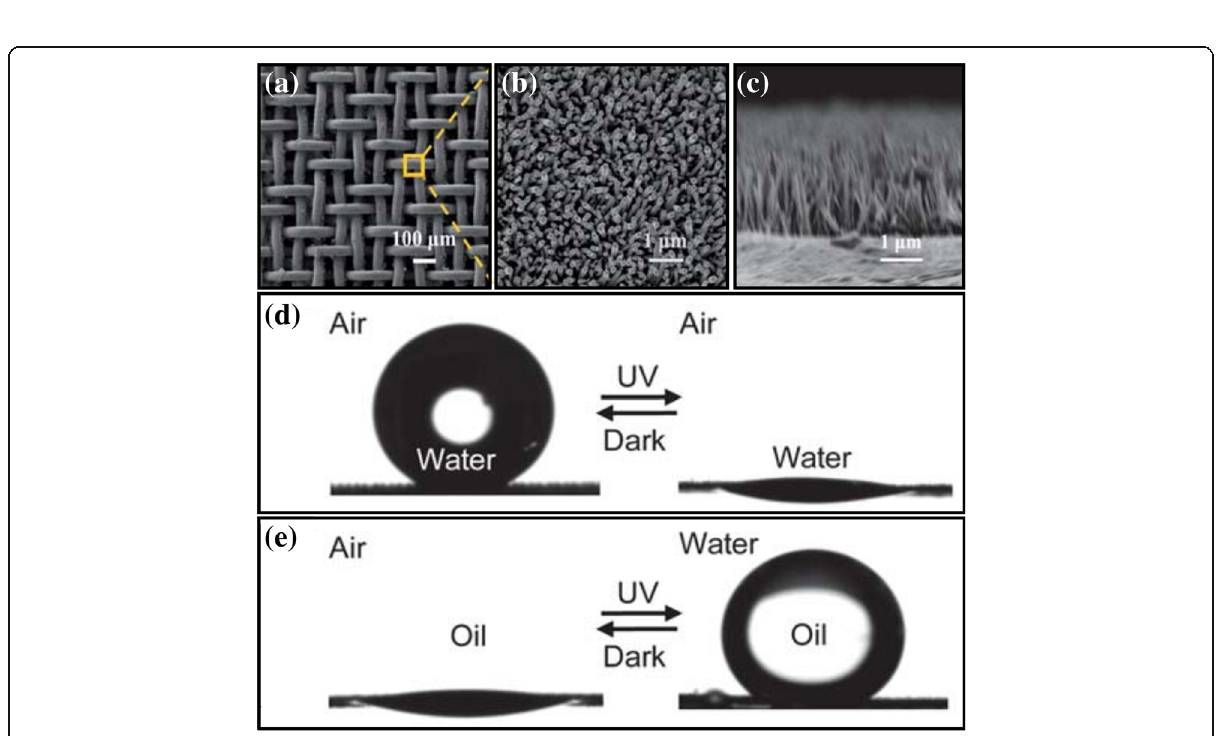
Fig. 10 a – c Schematic diagrams of the SEM images of as-prepared aligned ZnO nanorod array-coated stainless steel mesh films [80]. d Photographs of a water droplet on the coated mesh film after dark storage (left) and under UV irradiation (middle) in air with contact angles of ~ 155° and ~ 0°, respectively [80]. e Photographs of an oil droplet (1,2-dichloroethane) on the mesh film in air (left) and underwater (middle) with contact angles of ~ 0° and ~ 156°, respectively